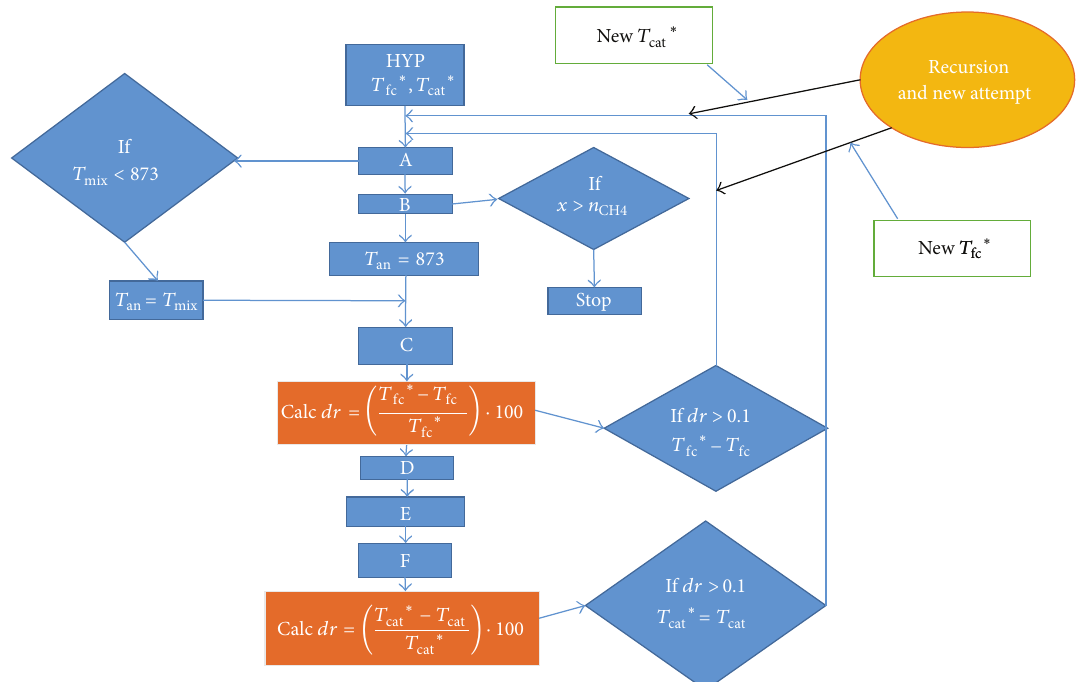
Figure 5: Flow diagram for the calculation of the parameters of the complete system.